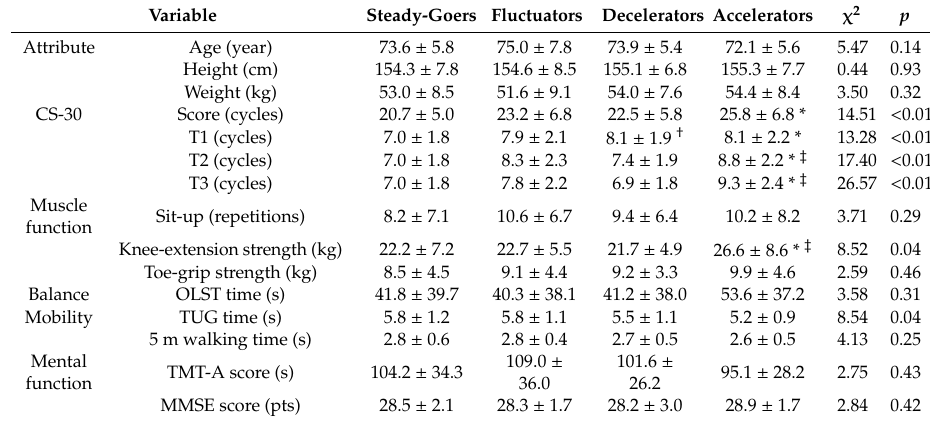
Table 2. Comparisons of the basic attributes and assessment items for each 30 s chair-stand test (CS-30) pattern.